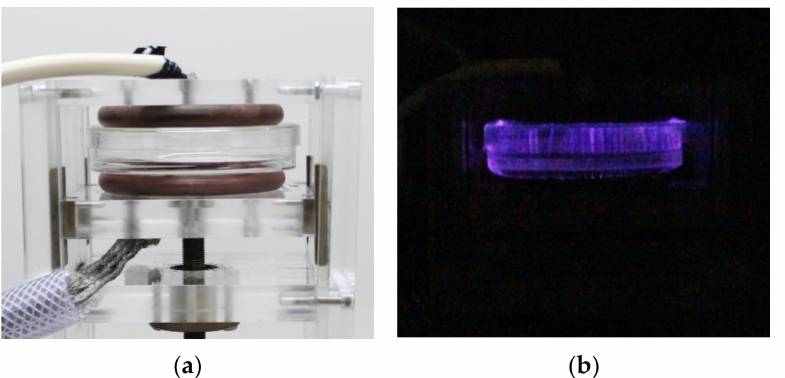
Figure 3. The electrode for applying pluses; ( a ) appearance of the electrode; ( b ) appearance of the generated plasma.